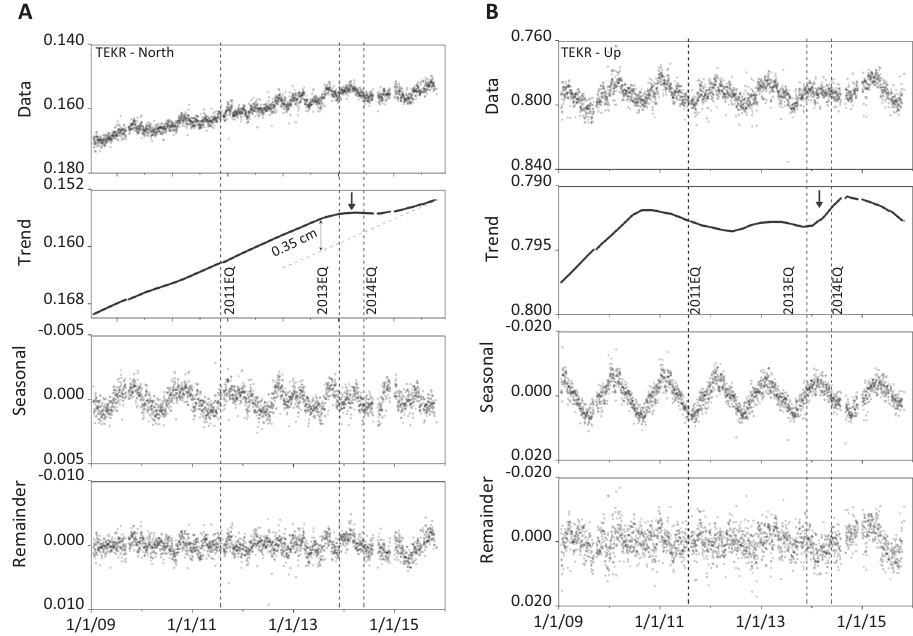
Fig. 2 Decomposition plot of TEKR GPS geodetic data. A Northern displacement and B vertical displacement. The unit on the vertical scale is meters. The horizontal scale uses the convention of day, month, and year. The timing of the three earthquakes (2011EQ, 2013EQ, and 2014EQ) are displayed by dashed vertical